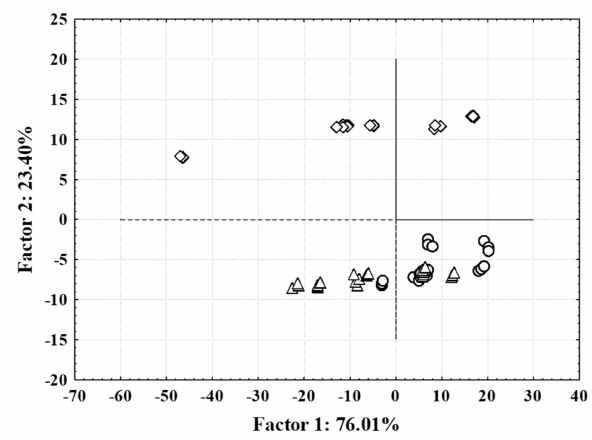
Figure 2. Principal component analysis of NIR spectra of ground ivy extracts: ( heat-assisted extraction; ( (cid:52) ) microwave-assisted extraction; (